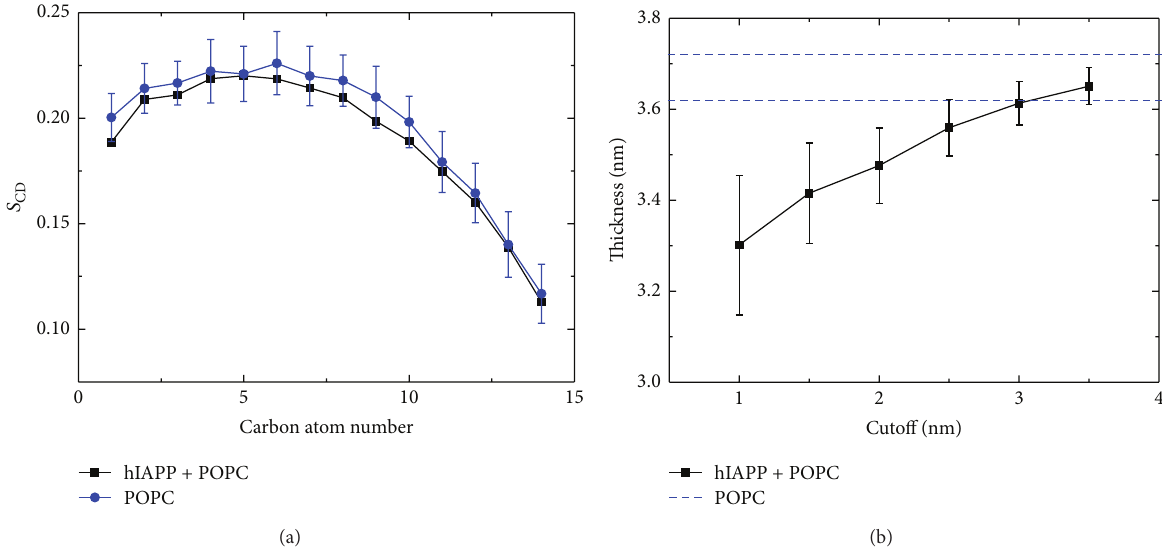
Figure 8: Influence of membrane-bound hIAPP monomer on the tail ordering of POPC lipids. (a) Lipid tail order parameter 𝑆 1 (sn-1). In the calculation, the lipids within 1nm (minimum distance) from any nonhydrogen atom of hIAPP peptide are considered. We also of a neat POPC lipid bilayer for comparison, obtained from the last 10ns of a 100ns MD run. (b) Local membrane thickness for give the 𝑆 CD lipids within six different cutoffs from hIAPP peptide. The thickness is calculated using the average 𝑧 -position of the phosphorus atoms in the upper leaflet and that in the lower leaflet. The upper and lower bounds of the thickness of a neat POPC bilayer membrane ( 36.7 ± 0.5 ˚A) are plotted in blue dashed lines, consistent with that in